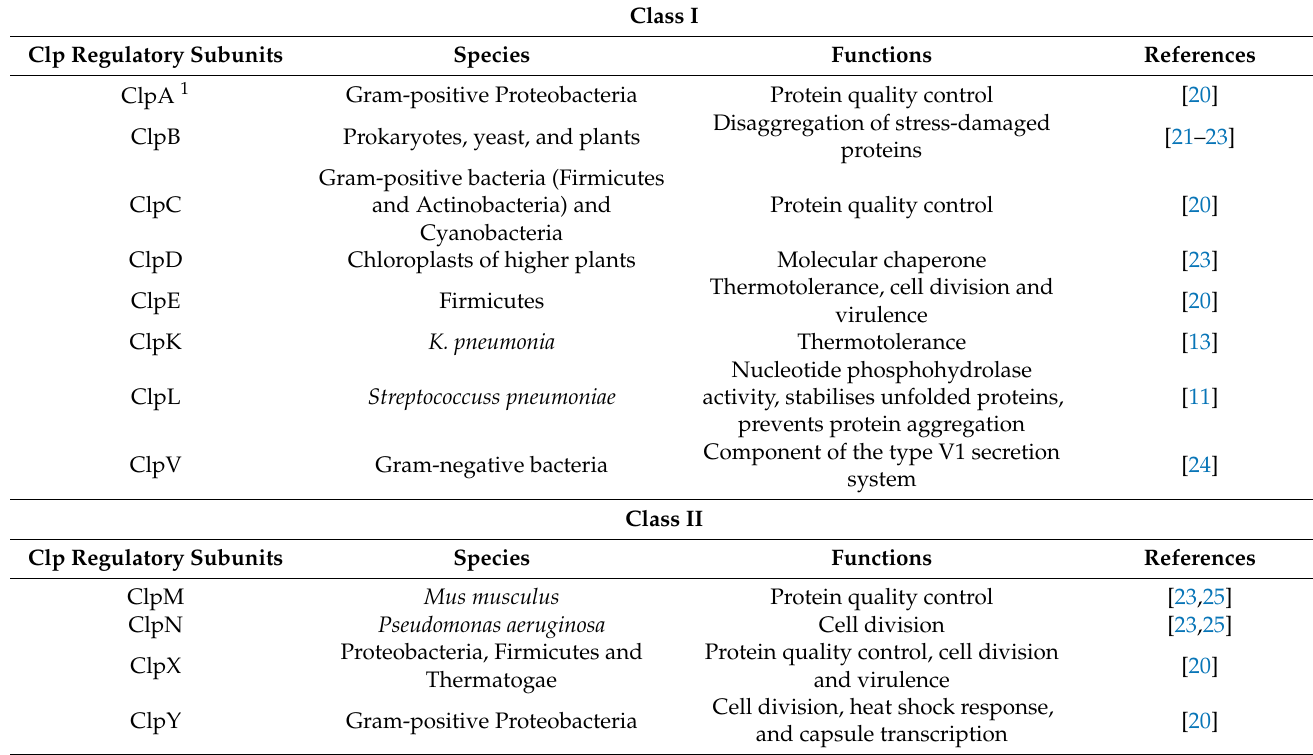
Table 1. Clp regulatory subunits identified across different proteins, exhibiting diverse